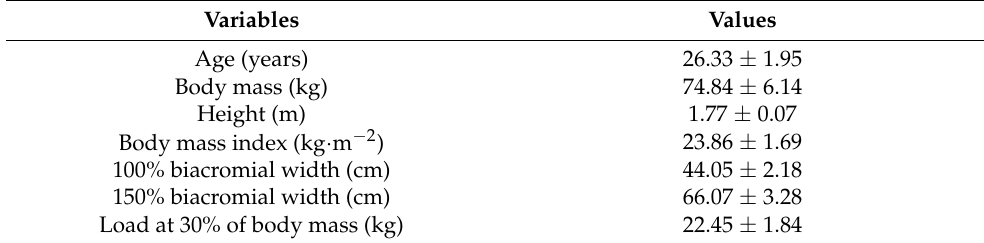
Table 1. General characteristics of the participants.